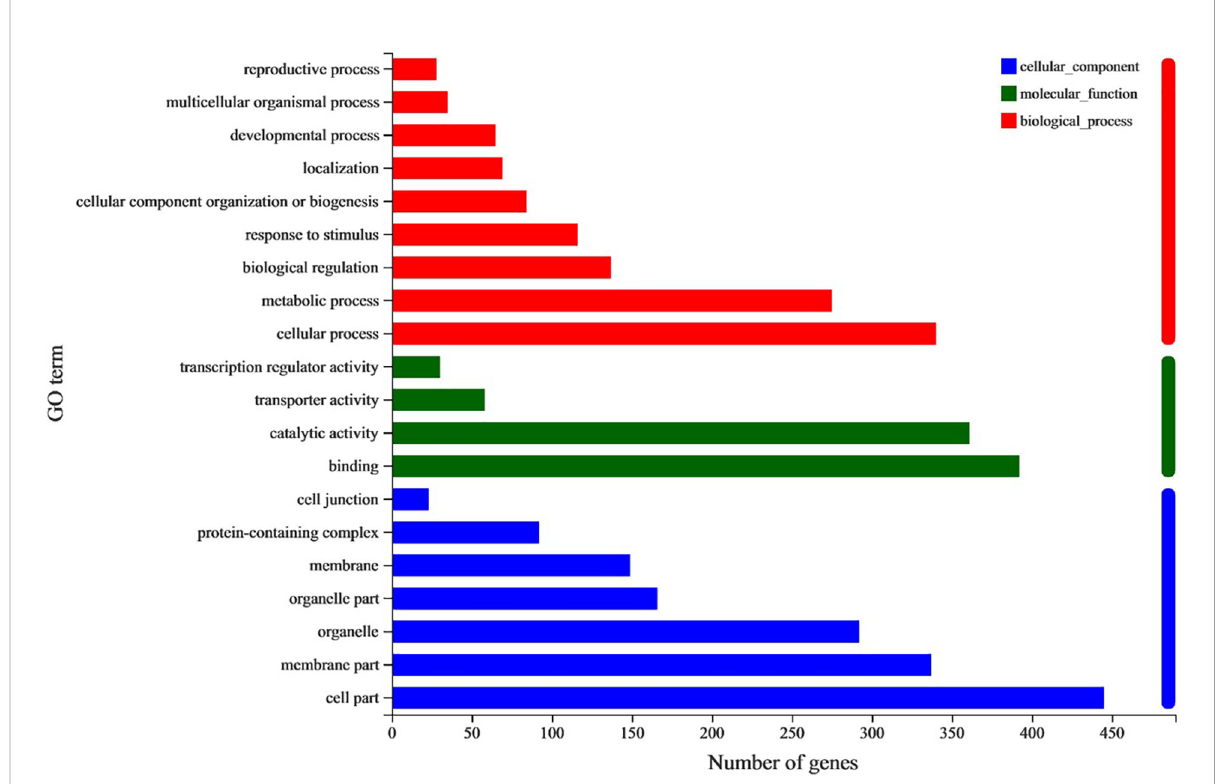
FIGURE 7 GO analysis of common DEGs between SU vs. LU and SD vs. LD. The horizontal and vertical axes show the number and enriched class of DEGs. Red columns, Biological process; Green columns, Molecular function; Blue columns, Cellular